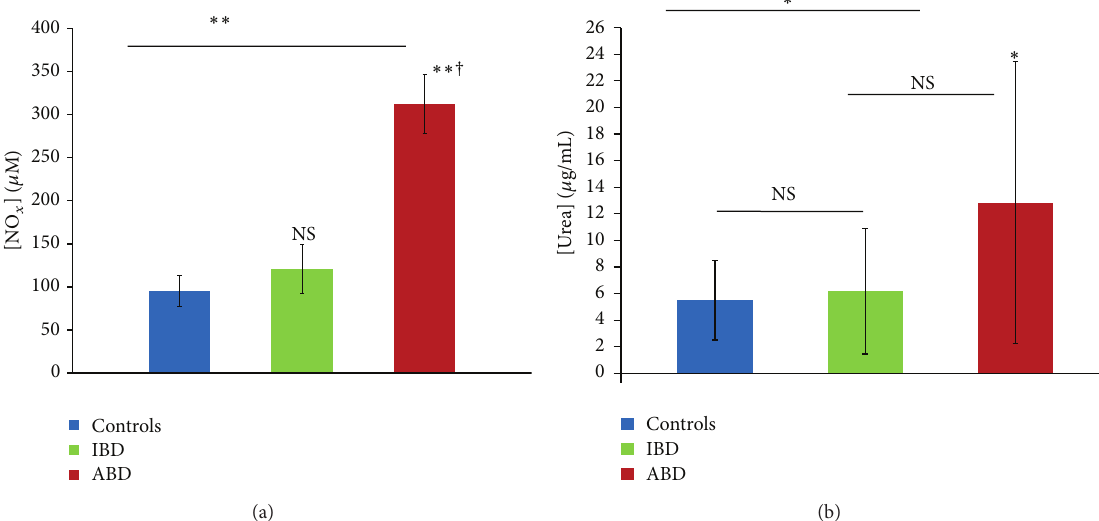
Figure 1: Plasmatic nitric oxide (a) and urea (b) levels in patients with BD ( 𝑛 = 36 ) during active stage (ABD) and inactive stage (IBD) and in control subjects (controls, 𝑛 = 15 ) (ns: 𝑃 > 0.05 ; ∗ : 𝑃 < 0.05 versus control subjects, ∗∗ : 𝑃 < 0.01 versus control subjects, † : ABD versus IBD 𝑃 < 0.05